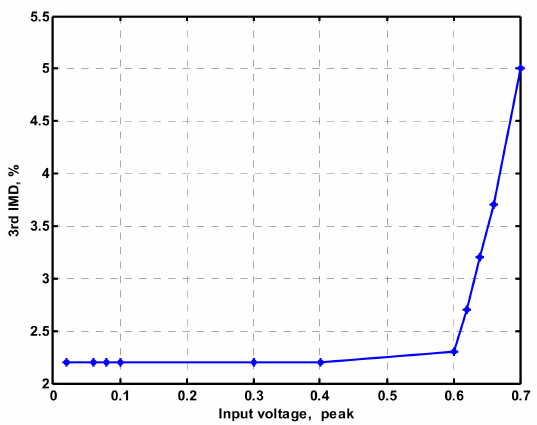
Figure 16. Dependence of the third-order IMD of the IBP filter on input signal amplitudes.